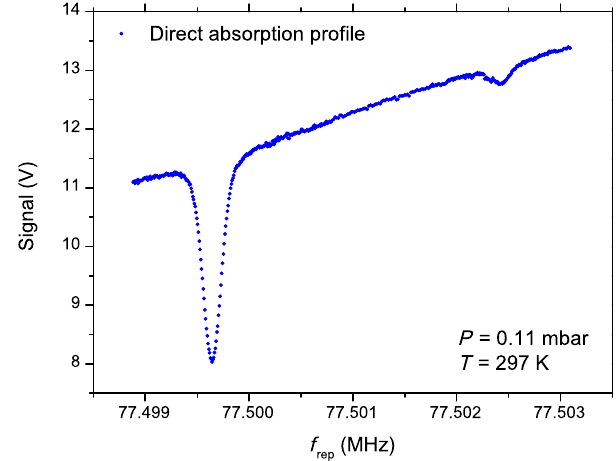
transitions.FIG. 2. Spectroscopic signal, recorded by tuning the repetition rate of the Ti:sapphire pump laser. Experimental conditions (gas pressure and temperature) are also reported.